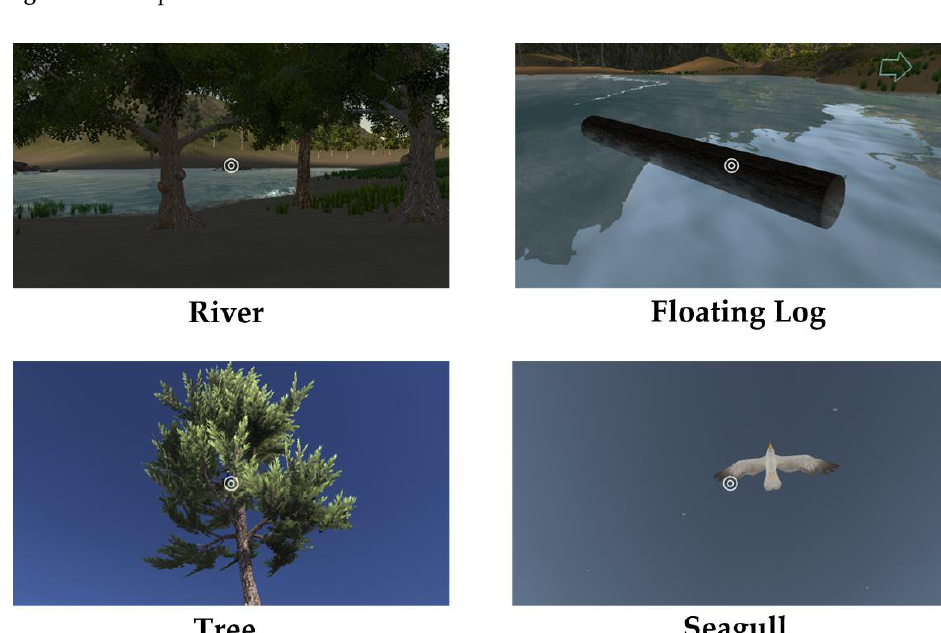
Figure 2. 3D VR objects.